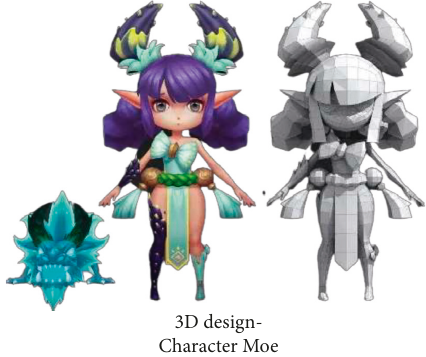
Figure 6: 3D cute anime characters.